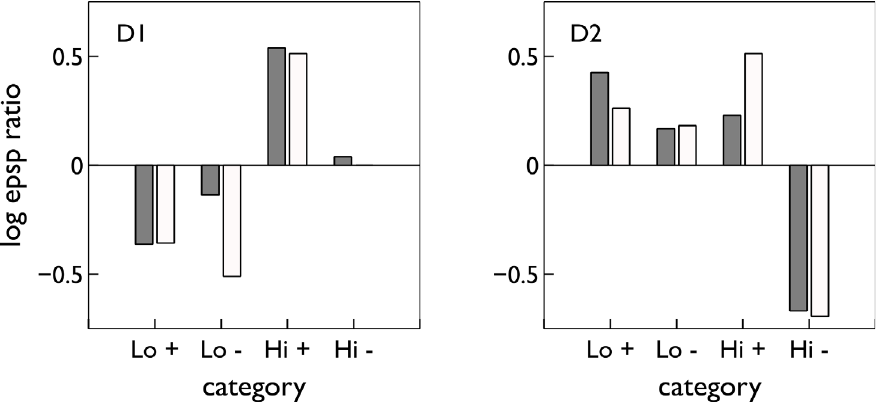
Figure 12. STDE model’s replication of Shen and colleagues’ plasticity results (plotted in the insets of Figure 4). Each bar is the log of the ratio of final-to-initial EPSP amplitude after a period of plasticity induction. Solid/open bars are for the model/data respectively and each condition refers to a level of dopamine concentration (‘‘hi’’ or ‘‘lo’’) and spike pair timing ( + / 2 for positive/negative pre-post timing). For each of D1- and D2-MSNs, plasticity coefficients were drawn from the sets deemed successful in the exhaustive search. In each case (D1 or D2) the four outcomes were uniformly scaled (under linearity of learning) to the best least-squares fit.